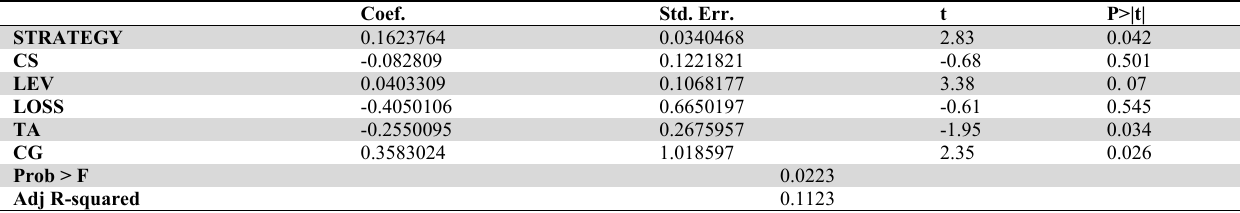
Regression results between strategy and conservatism